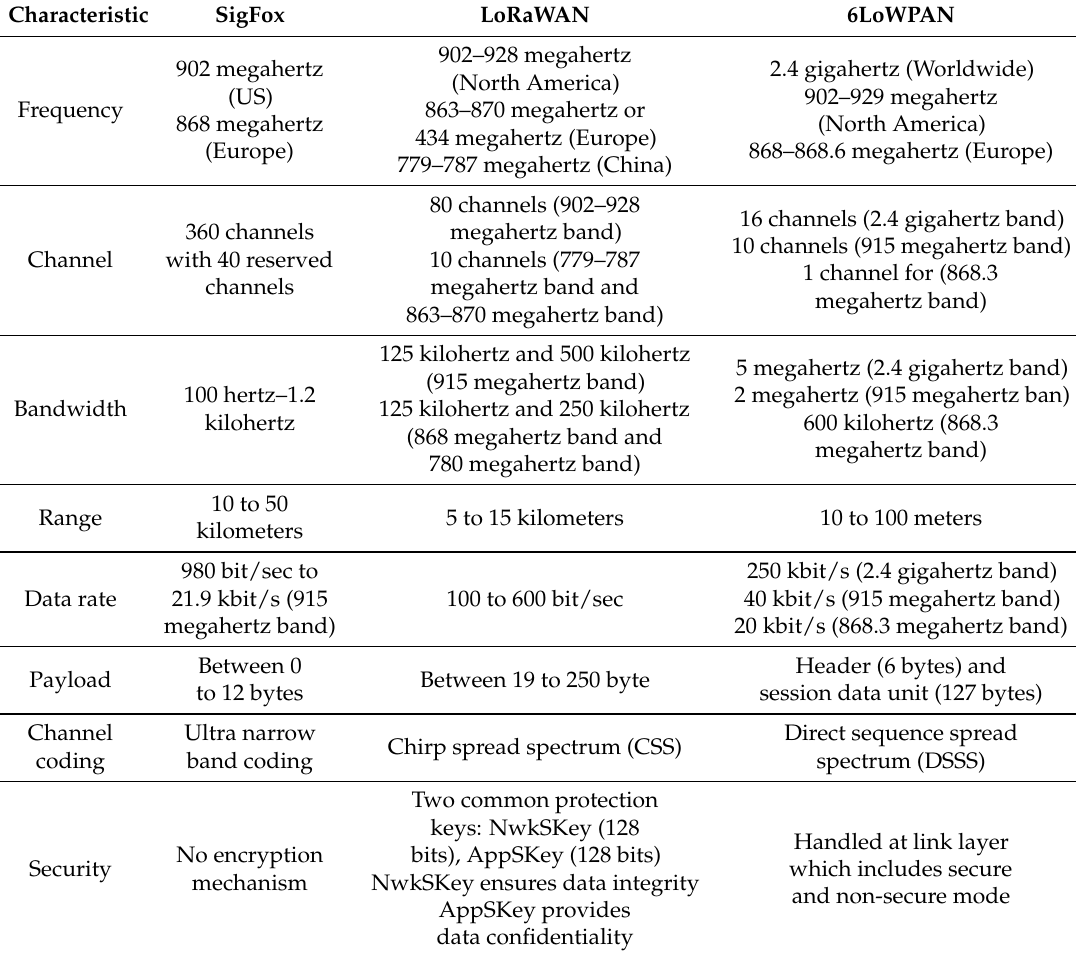
Table 3. Comparison between different characteristics of SigFox, LoRaWAN, and 6LoWPAN medium range communication